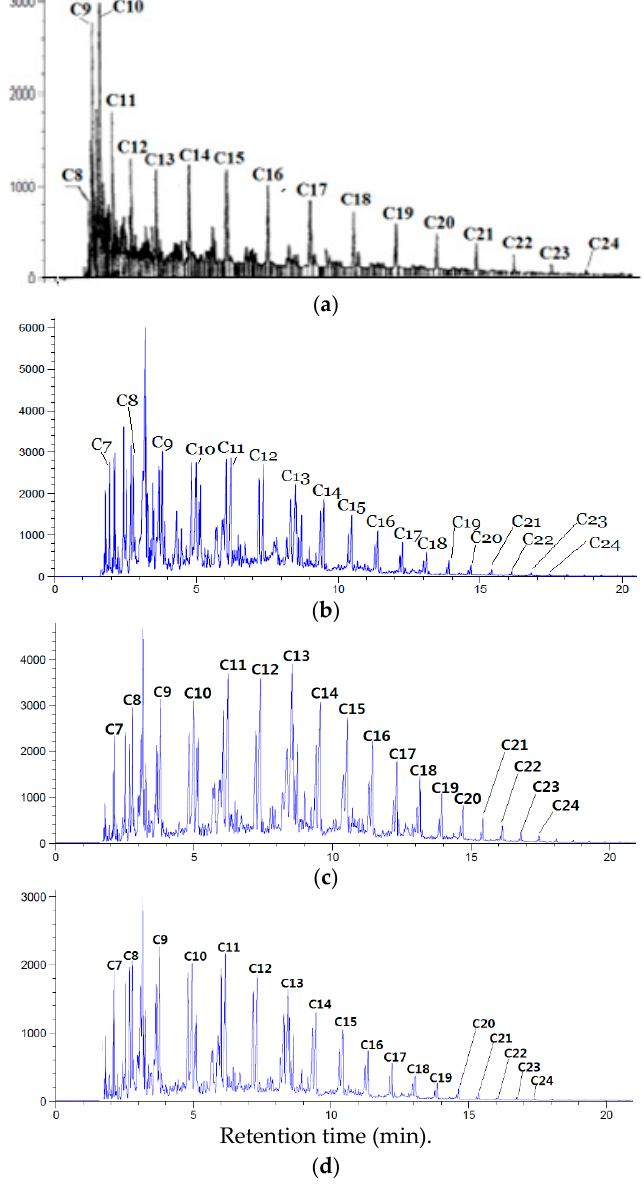
Figure 1. Gas chromatogram of ( a ) commercial light oil, ( b ) raw material (distillate recovered from WPPO through simple distillation), ( c ) ra ffi nate (solvent-free) recovered using dimethylformamide (DMF), and ( d ) ra ffi nate (solvent-free) recovered using dimethylsulfoxide (DMSO). Experimental conditions of ( c ) and ( d ): t = 72 h, y w,0 = 0.03, (S / F) 0 = 10, T 0 = 28 ◦